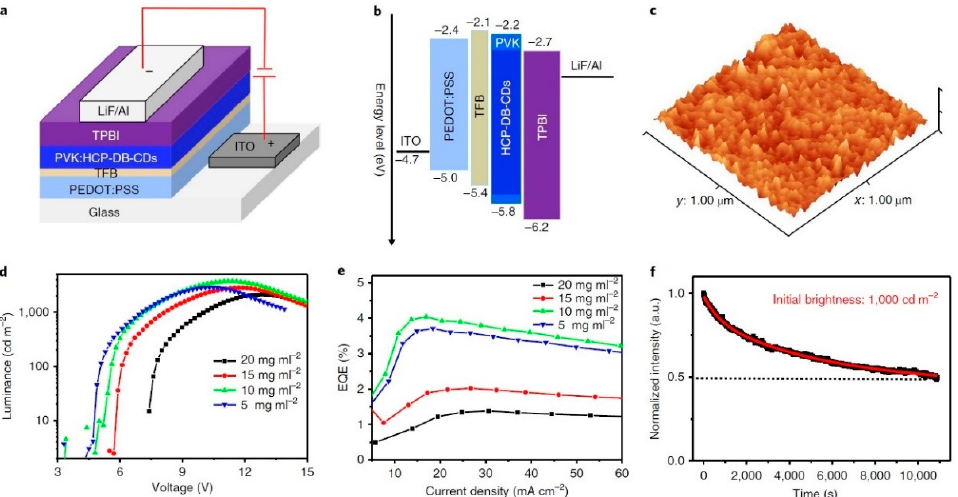
Figure 16. ( a ) PVK:CD-based device structure, ( b ) the energy level diagram, ( c ) the AFM height image of PVK:CD films, ( d ) the L-V curves, ( e ) the EQE–J characteristics, and ( f ) the device stability: Reproduced with permission from [77], cop-